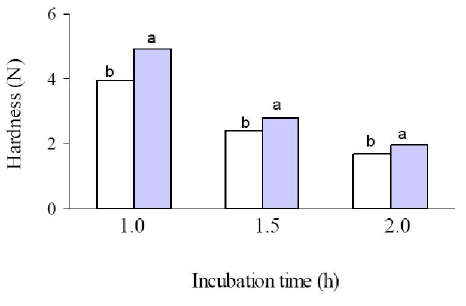
Figure 2. Hardness of WBAX gels at 5% (  ) and 6% (  ) in WBAX extracted using different incubation times. Values are means of triplicate measurements. All the given values are means of three determinations. Mean values for the same incubation time with different letters are significantly different (P <